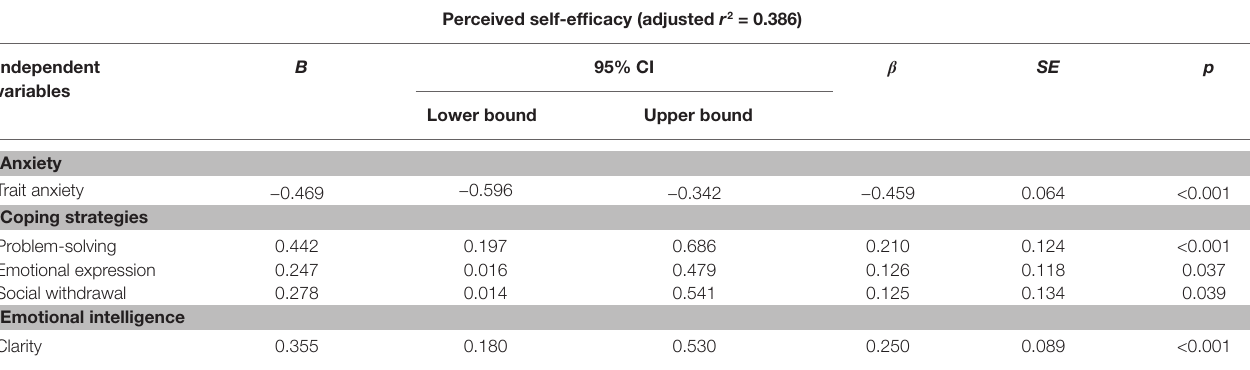
TABLE 3 | Regression model of anxiety, coping strategies, and emotional intelligence predictive associated factors to perceived self-efficacy in university students.